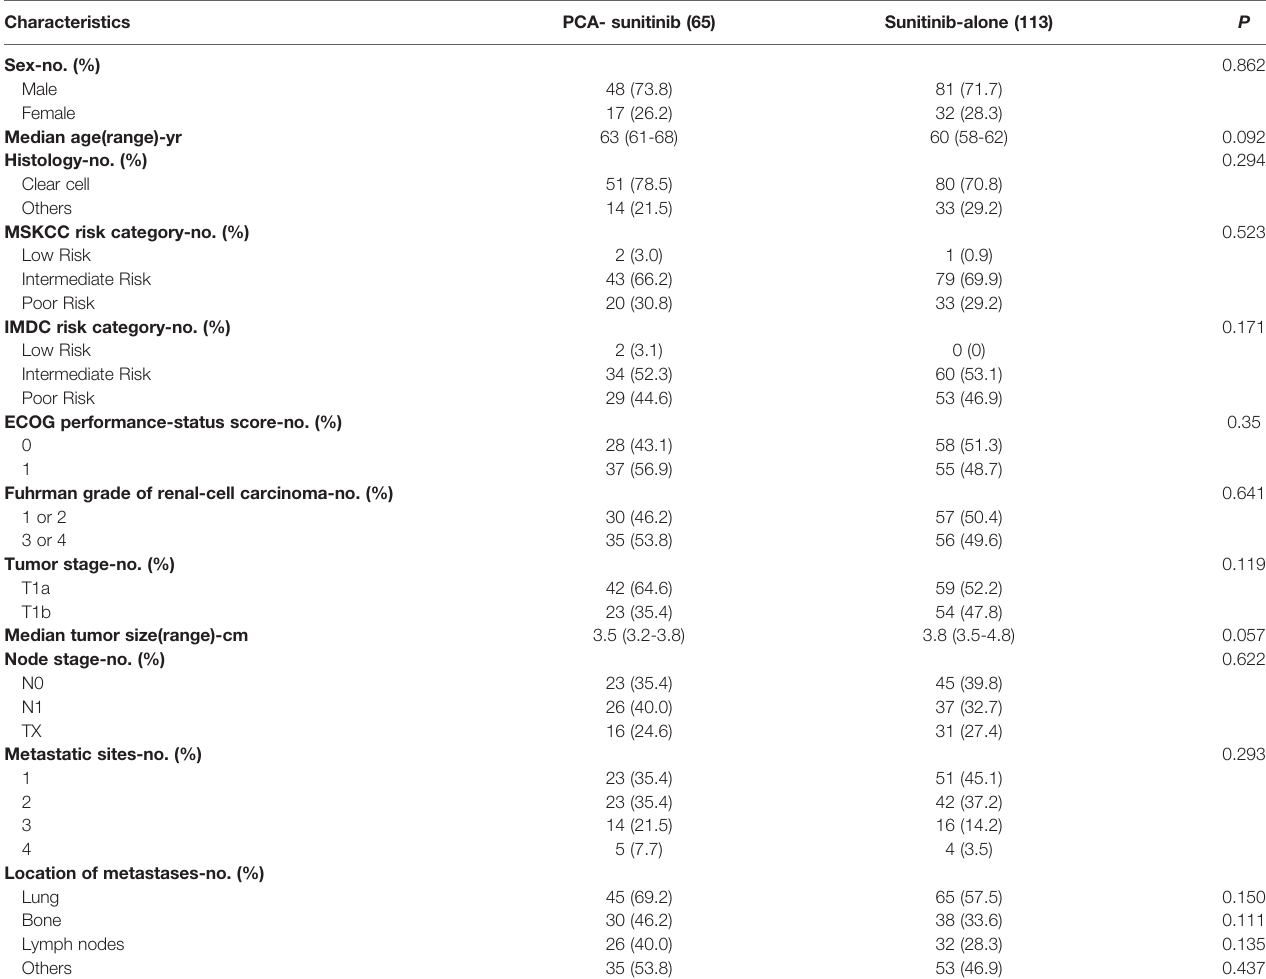
TABLE 1 | Baseline characteristics